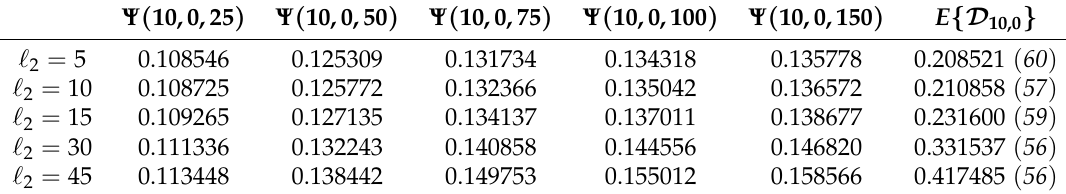
Table 3. Finite-time ruin probabilities and expected total discounted dividends paid prior to ruin